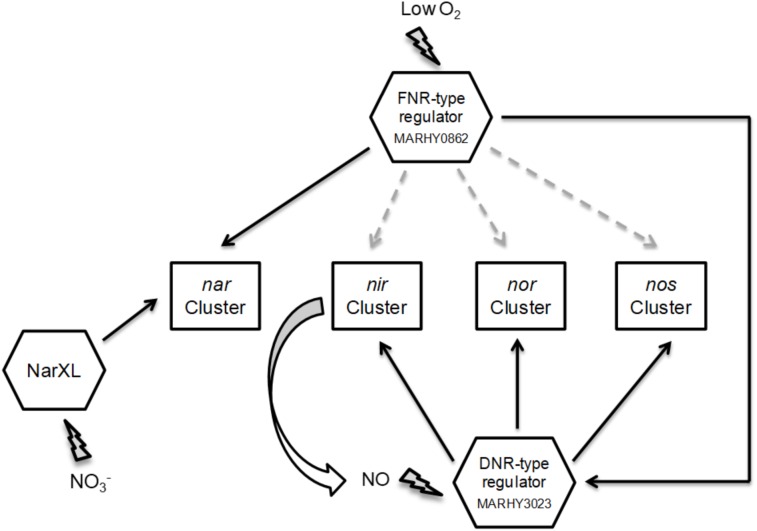
Putative regulatory network controlling denitrification gene expression in M. hydrocarbonoclasticus.The main effector involved in regulation of nitrate reductase (nar), nitrite reductase (nir), nitric oxide reductase (nor) and nitrous oxide reductase (nos) gene clusters is the low oxygen tension through a FNR-type regulator. Secondary effectors are nitric oxide (NO) (first produced by the initial low levels of nitrite reductase) involved in expression regulation of nir, nor and nos genes clusters, through a DNR-type regulator, and nitrate (NO\documentclass[12pt]{minimal}
\usepackage{amsmath}
\usepackage{wasysym}
\usepackage{amsfonts}
\usepackage{amssymb}
\usepackage{amsbsy}
\usepackage{upgreek}
\usepackage{mathrsfs}
\setlength{\oddsidemargin}{-69pt}
\begin{document}
}{}${}_{3}^{-}$\end{document}3−) involved in regulation of nar genes through the two-component system NarXL. Our own bioinformatic analyses suggest that MARHY0862 and MARHY3023 are, respectively, the FNR and DNR homologues involved in regulation of denitrification gene expression in M. hydrocarbonoclasticus. Dash lines indicate the putative but lower level of nir, nor and nir gene regulation by FNR.